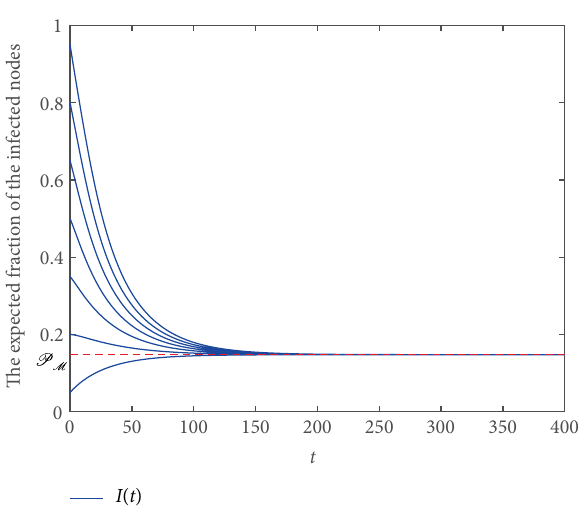
Figure 5: The evolution of the expected fraction of the infected nodes in Example 1.